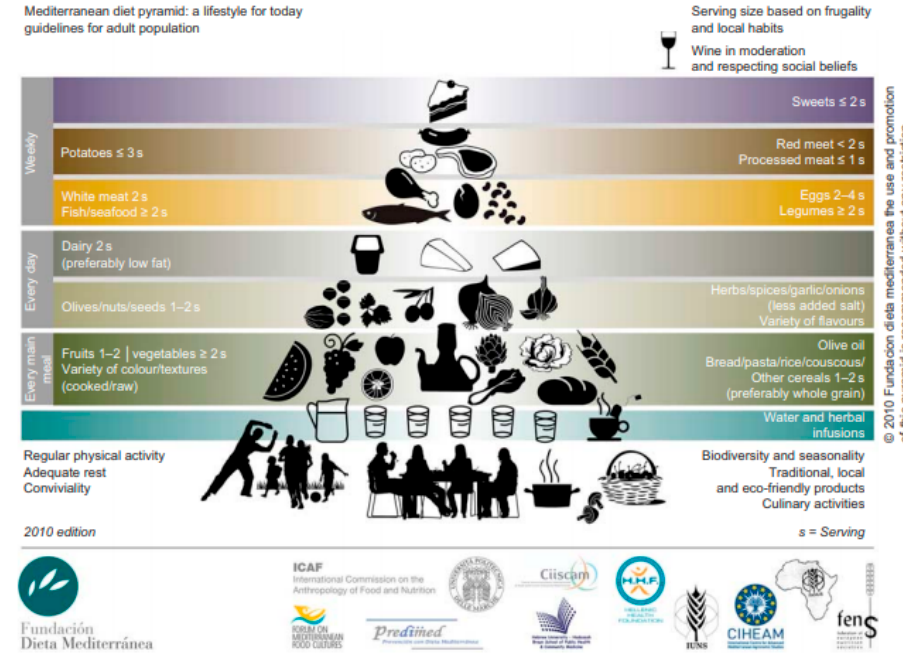
Figure 1. Mediterranean diet pyramid: A lifestyle for today [24].